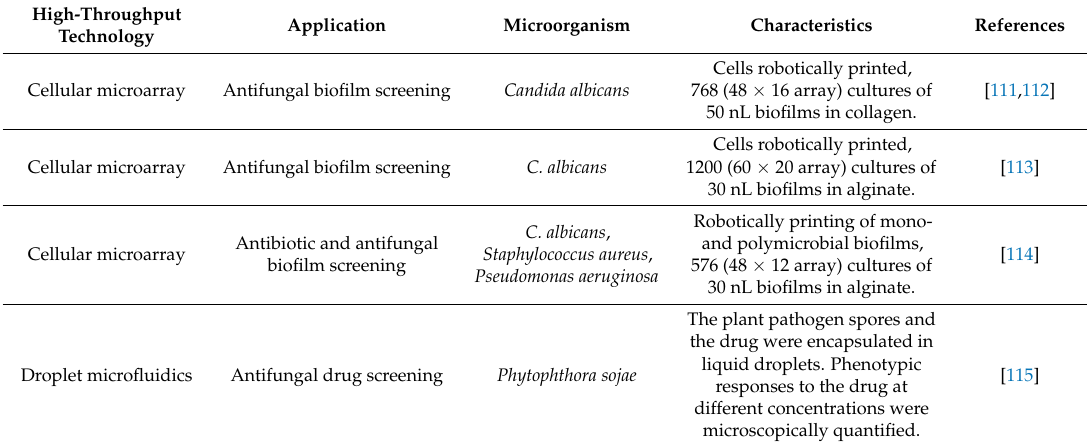
Table 2. Examples of microfluidic platforms for high-throughput antifungal drug